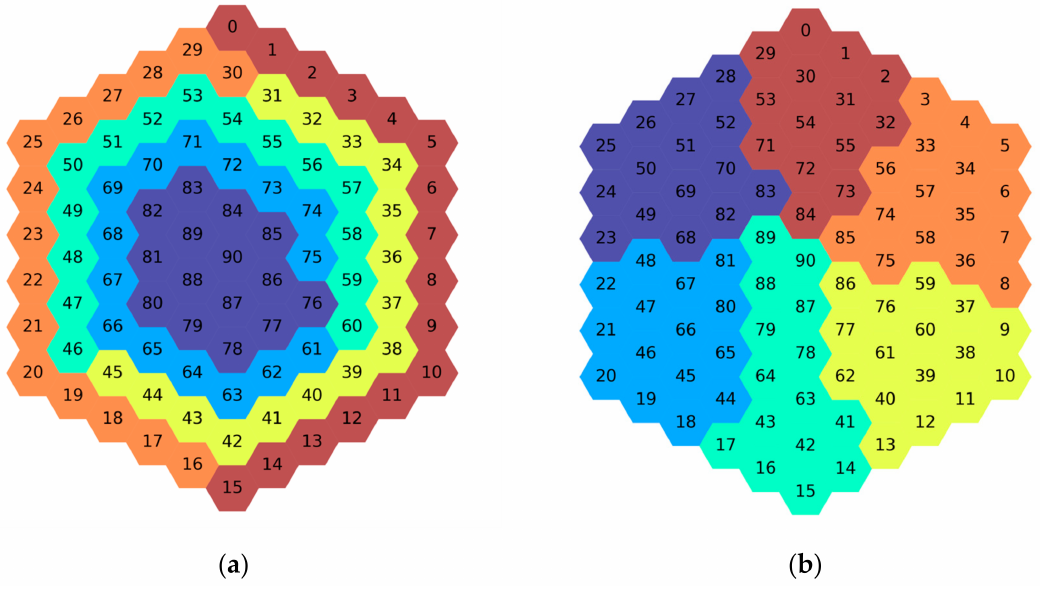
Figure 7. The cross-node allocation diagram of process and its corresponding assemblies before and after optimization: ( a ) before optimization; ( b ) after